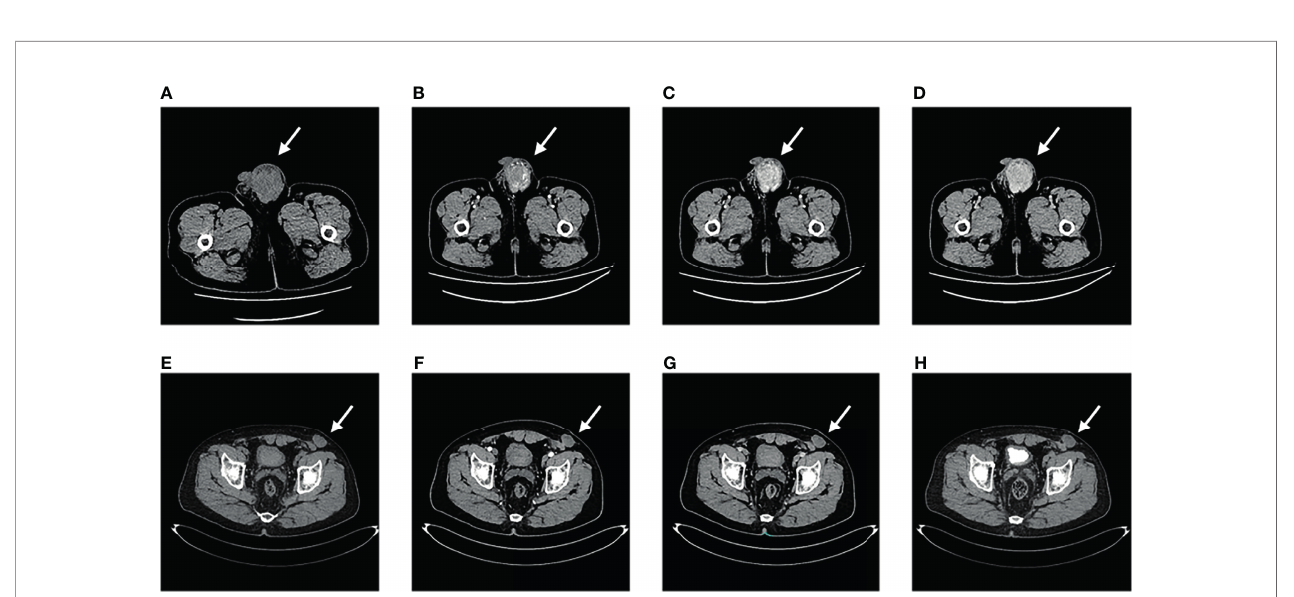
FIGURE 2 | Computed tomography fi ndings. Pelvic computed tomography of primary tumour (A – D) . (A) Plain scan. (B) Arterial phase. (C) Venous phase. (D) Excretion phase. Pelvic computed tomography of recurrent tumour (E – H) . (E) Plain scan. (F) Arterial phase. (G) Venous phase. (H) Excretion